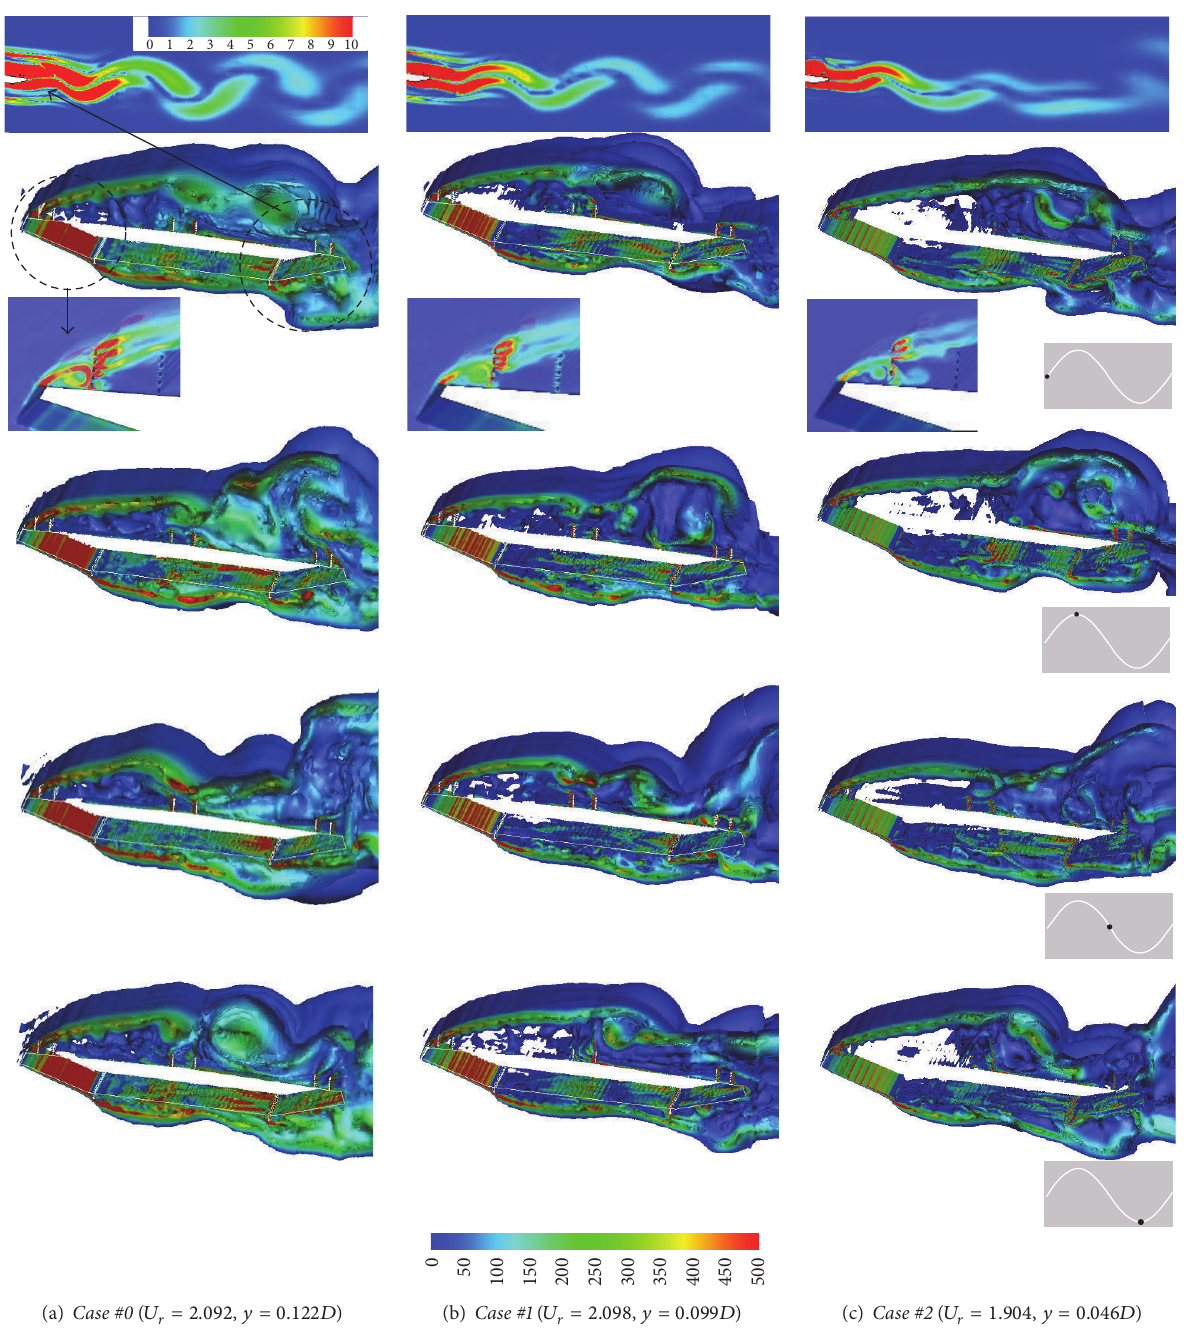
Figure 17: Instantaneous vorticity contours in a periodic vertical VIV ( 𝛼 = +5 ∘